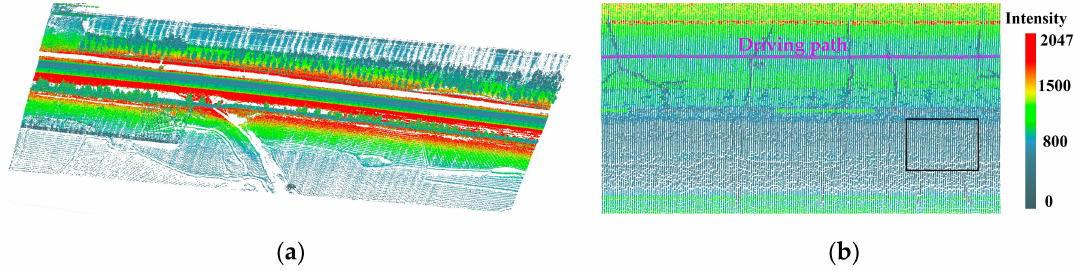
Figure 1. The test data. ( a ) The overall view of test data, and ( b ) the divergent point intensity in two